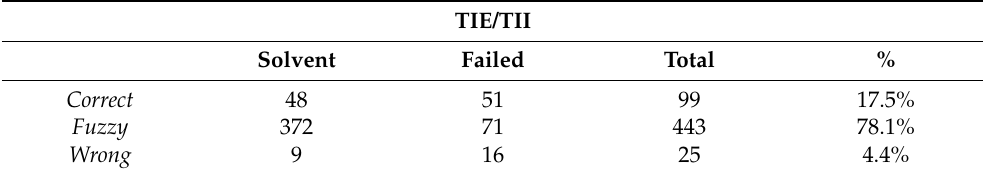
Table 5. The efficiency of the TIE/TII-based network.